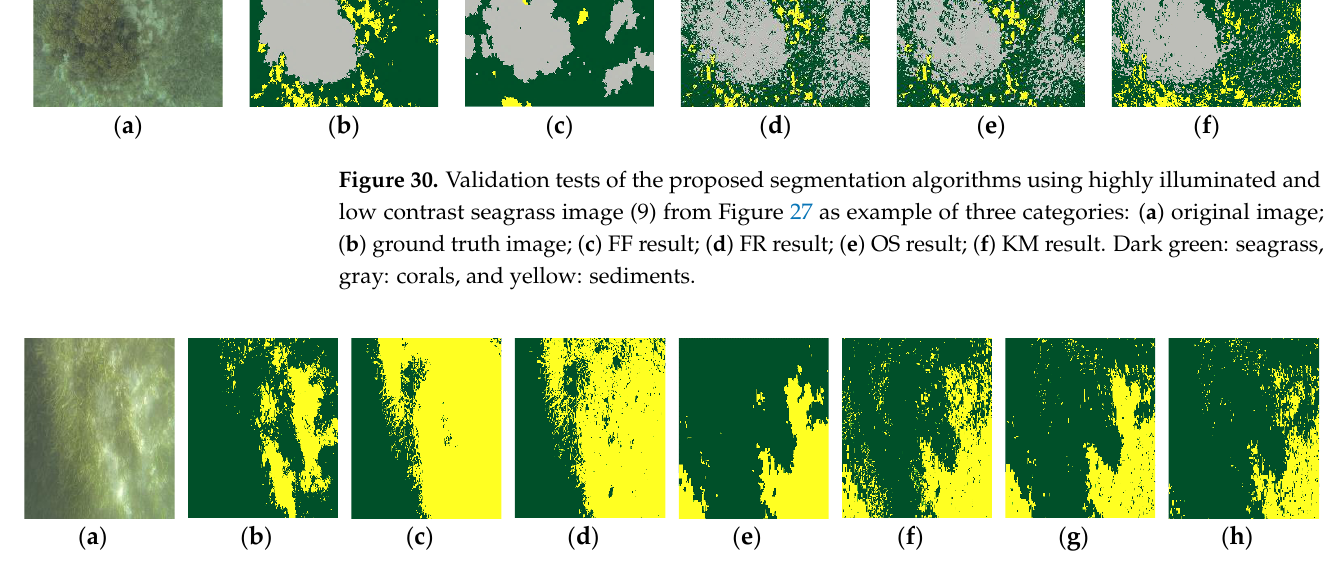
Figure 31. Validation tests of the proposed segmentation algorithms using low illuminated and high contrast seagrass image (1) from Figure 28 as example of two categories: ( a ) original image; ( b ) ground truth image; ( c ) KM result; ( d ) KMAc result; ( e ) FFCr result; ( f ) FRCr result; ( g ) OSCr result; ( h ) KMCr result. Dark green: seagrass, and yellow: sediments.